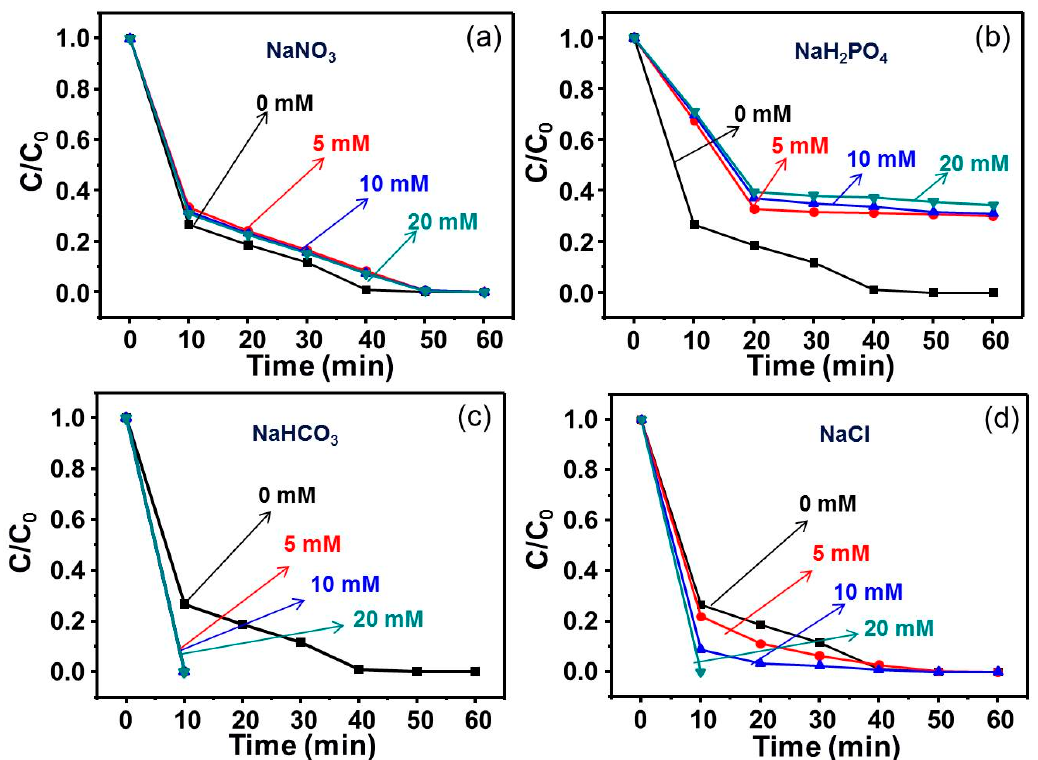
Figure 8. The effects of different anions ( a ) NO 3 − , ( b ) H 2 PO 4 − , ( c ) HCO 3 − , and ( d ) Cl − on the degradation of RhB.